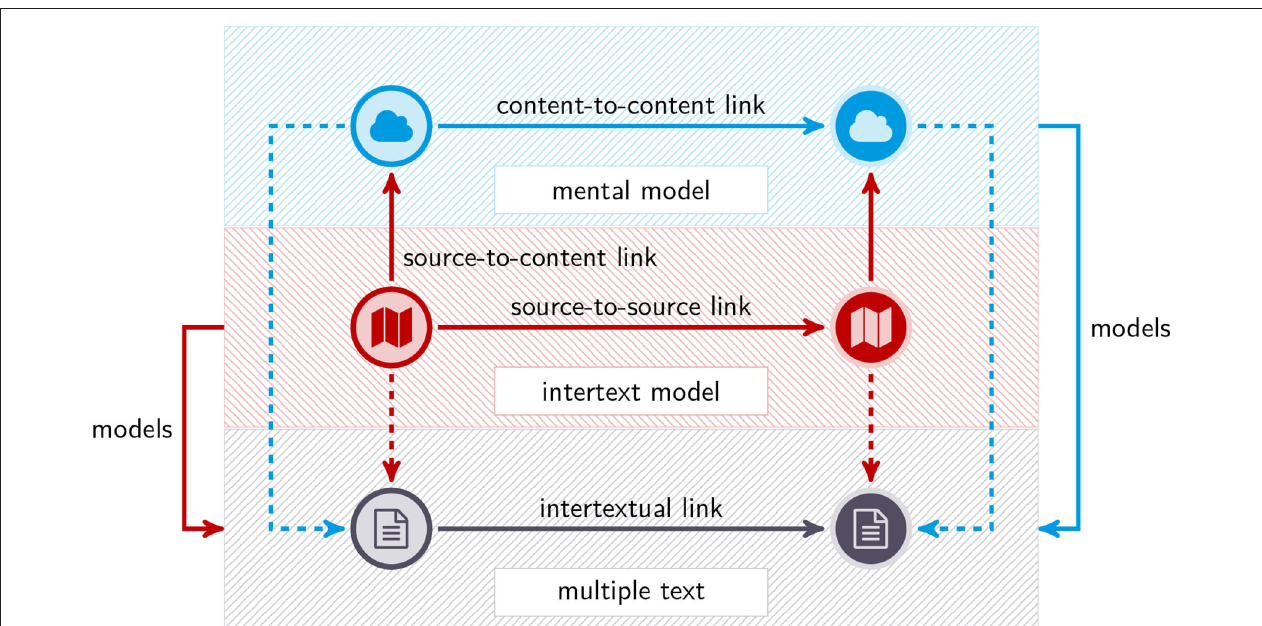
FIGURE 1 | Intertext model and mental model in relation to multiple texts: units and